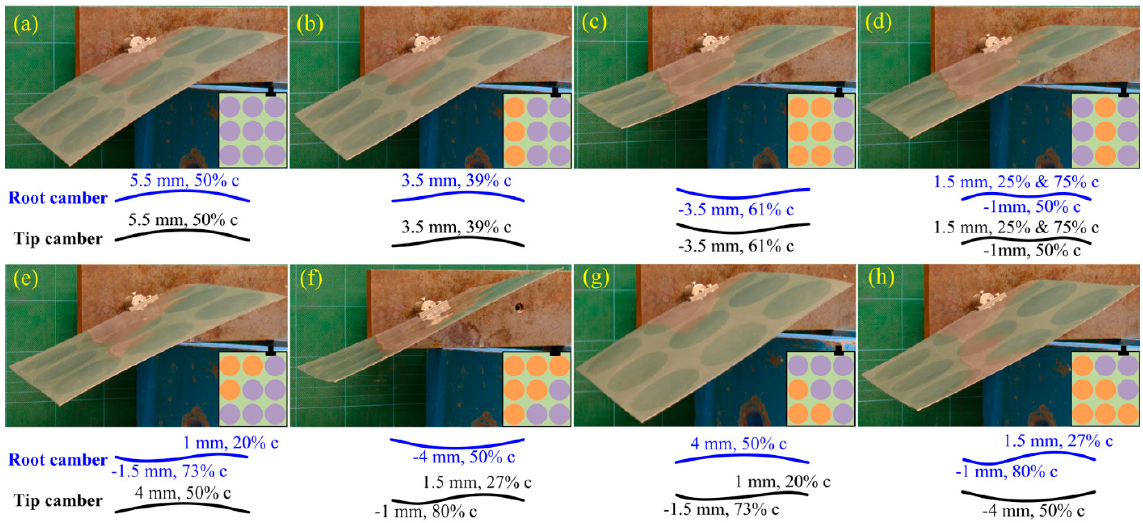
Figure 2. Eight stable configurations ( a – h ) of nanostructure-induced multistable shell. The orange and purple circles in every inset indicate the nanostructured zones capping up and down, respectively. The maximum capping deflections and locations (distance from the leading edge over the camber length) for each configuration at the root and tip cambers are shown with schematic camber curves.